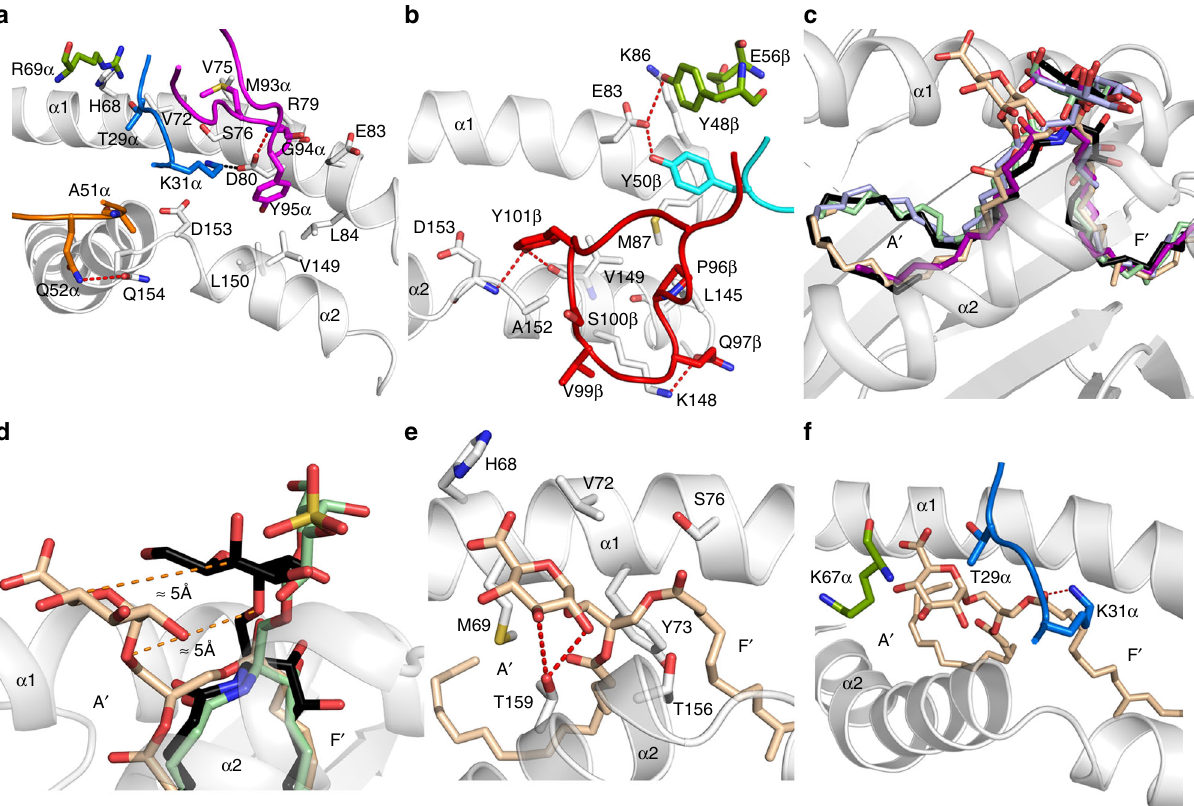
Fig. 5 Molecular interactions at the A11B8.2 TCR/CD1d – α -GlcADAG interface. a A11B8.2 TCR α -chain interactions with CD1d. b A11B8.2 TCR β